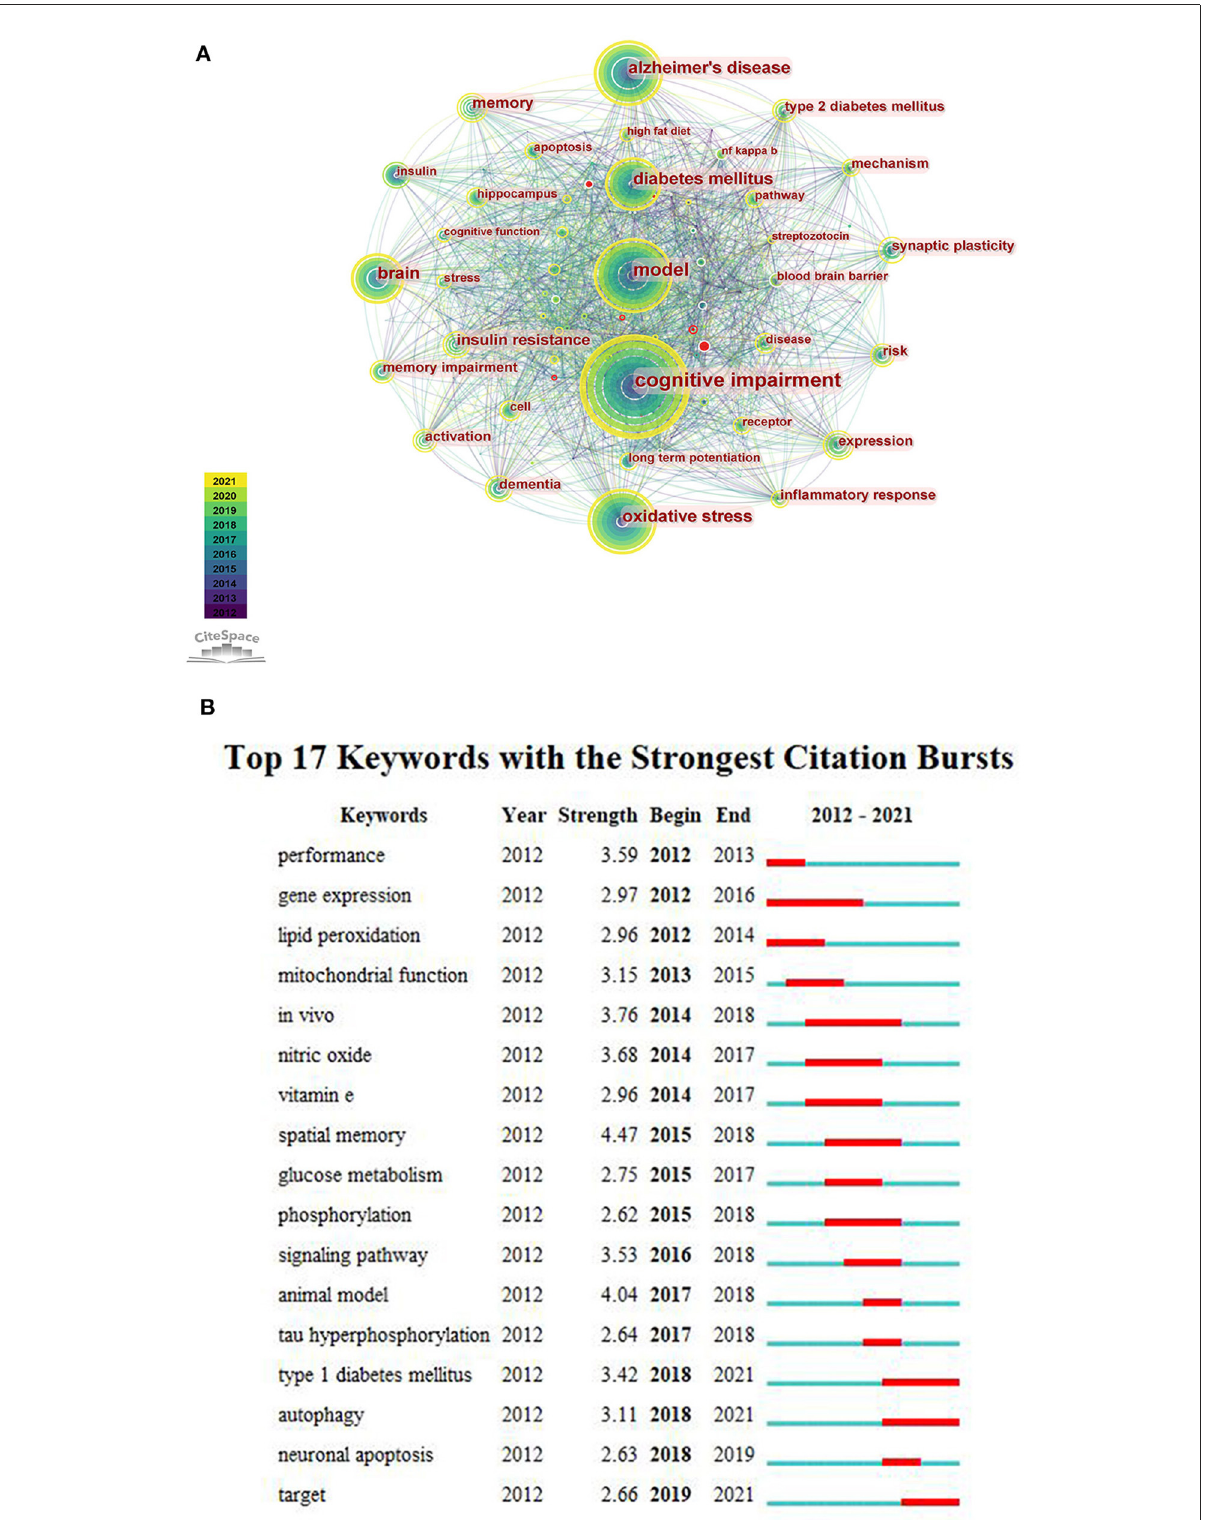
FIGURE5 (A) The co-occurrence network of keywords. (B) The top 17 keywords with the strongest citation